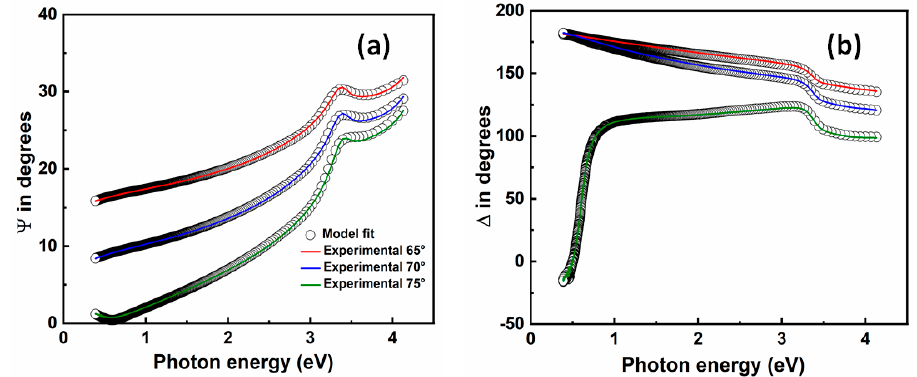
Figure 5. Variable angle spectroscopic ellipsometry measurements of thermally reduced graphene oxide films on SiO 2 / Si substrates. Experimental and model generated ψ ( a ) and ∆ ( b ) data fits at different angles of incidence.